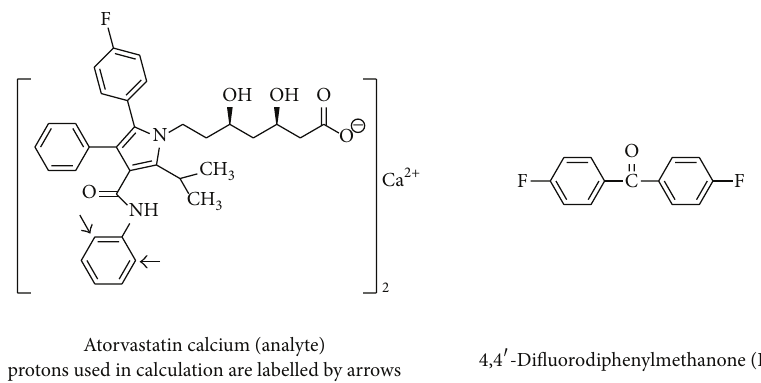
Figure 1: Structures of atorvastatin calcium and 4,4 󸀠